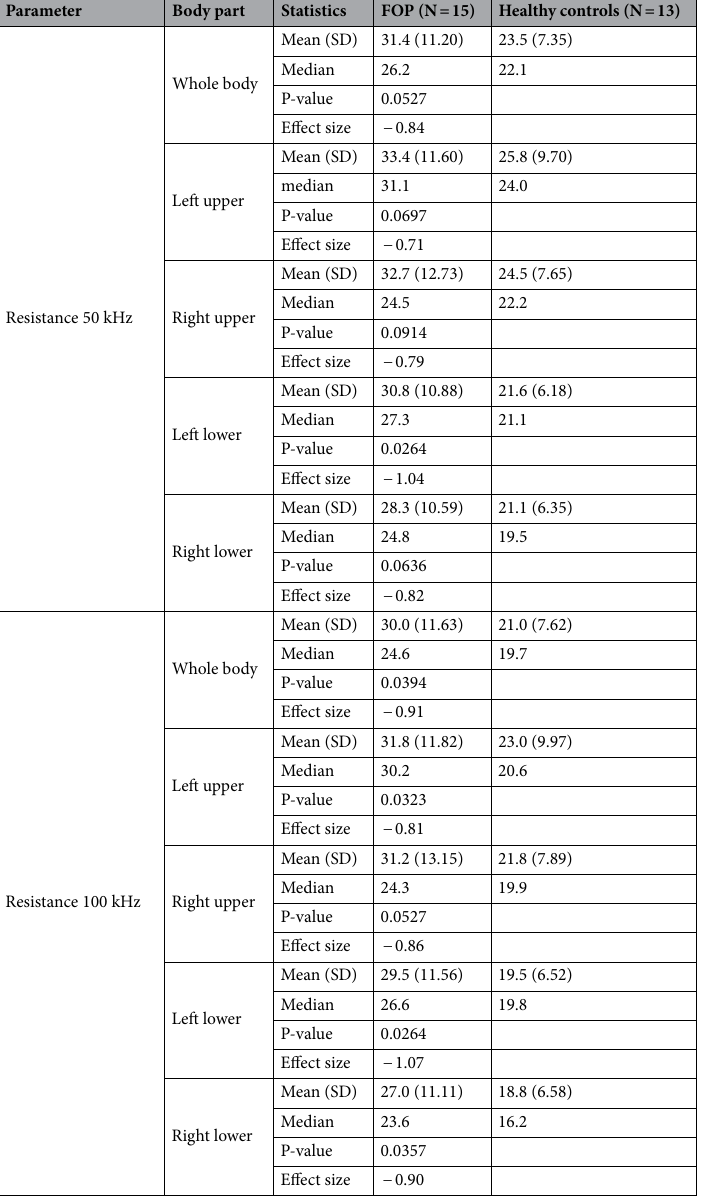
Table 2. Comparison of reactance and resistance values at 50 and 100 kHz in patients with FOP versus healthy controls. SD standard deviation. P-value derived from a Wilcoxon two-sample test comparing the mean difference between FOP patients and healthy controls. Effect Size (Mean of Healthy Control − mean of FOP Patients)/Pooled STD; Pooled STD = sqrt[(std1 2 + std2 2 )/2] std1 and std2 are the standard deviation of Healthy Control and FOP,